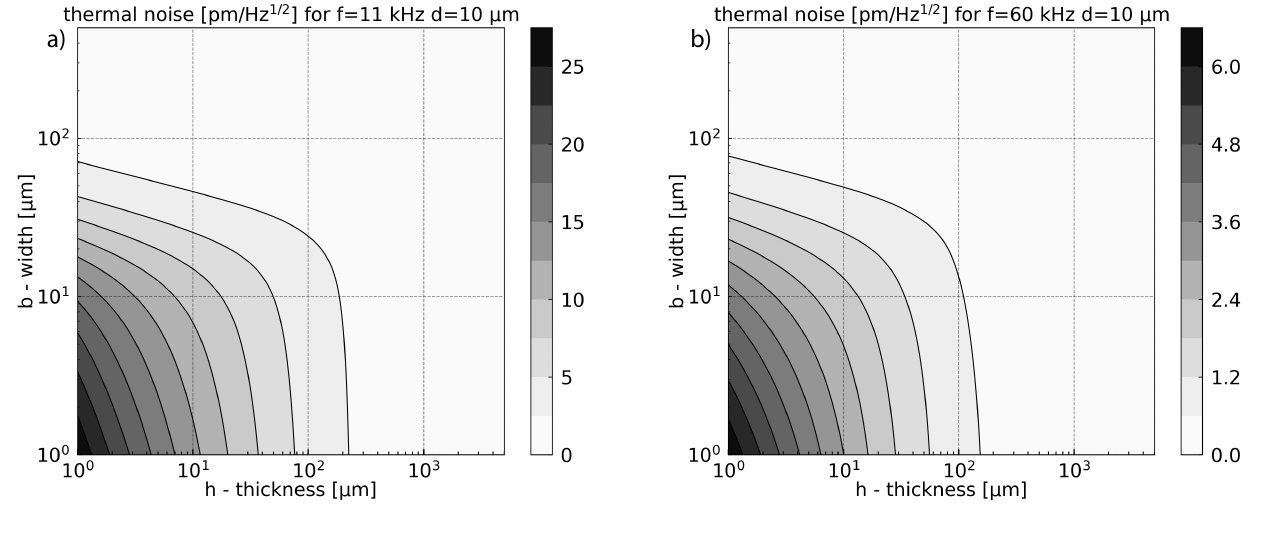
Figure A4. Thermal noise as a function of width and thickness of a cantilever. Cantilever’s fundamental resonance frequency: 11 kHz ( a ) and 60 kHz ( b ), gap between support and cantilever: d = 10 µ